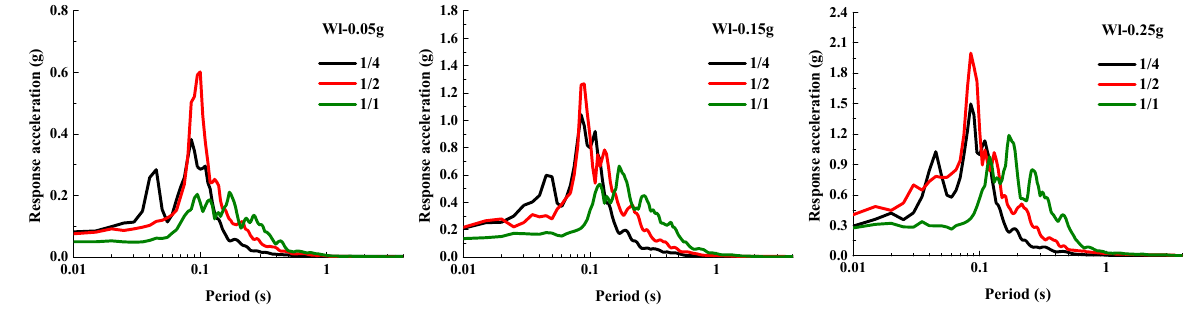
Figure 13. Acceleration response spectra of the measuring point AX6 under scaled Wolong records. This implies that the spectra were affected by the model soil and the amplitudes increased greatly in the specified period range (about 0.1 s), especially for the scaled El Centro record. There were obvious differences in seismic response of model soil with the duration compression ratios of 1/4, 1/2, and 1/1. Under the input of the El Centro record, for the frequency band with the periods less than 0.2 s, the differences between duration compression ratios of 1/4 and 1/2 were relatively small, and for the frequency band with the periods greater than 0.2 s, the differences between duration compression ratios of 1/2 and 1/1 were relatively small. Under the input of the Wolong record, the differences between duration compression ratios of 1/4, 1/2, and 1/1 were large, which differed from the re- sponse law of El Centro record. The characteristics of the test results for the three input